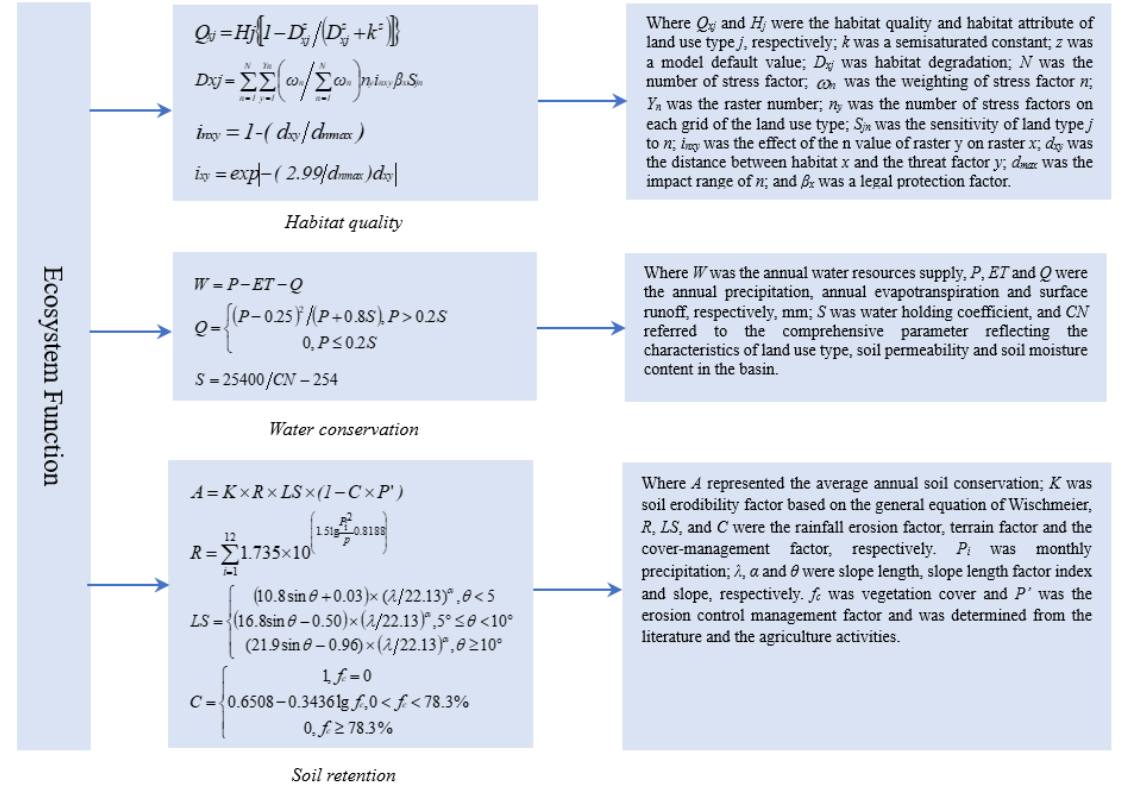
Figure 3. Ecosystem function.